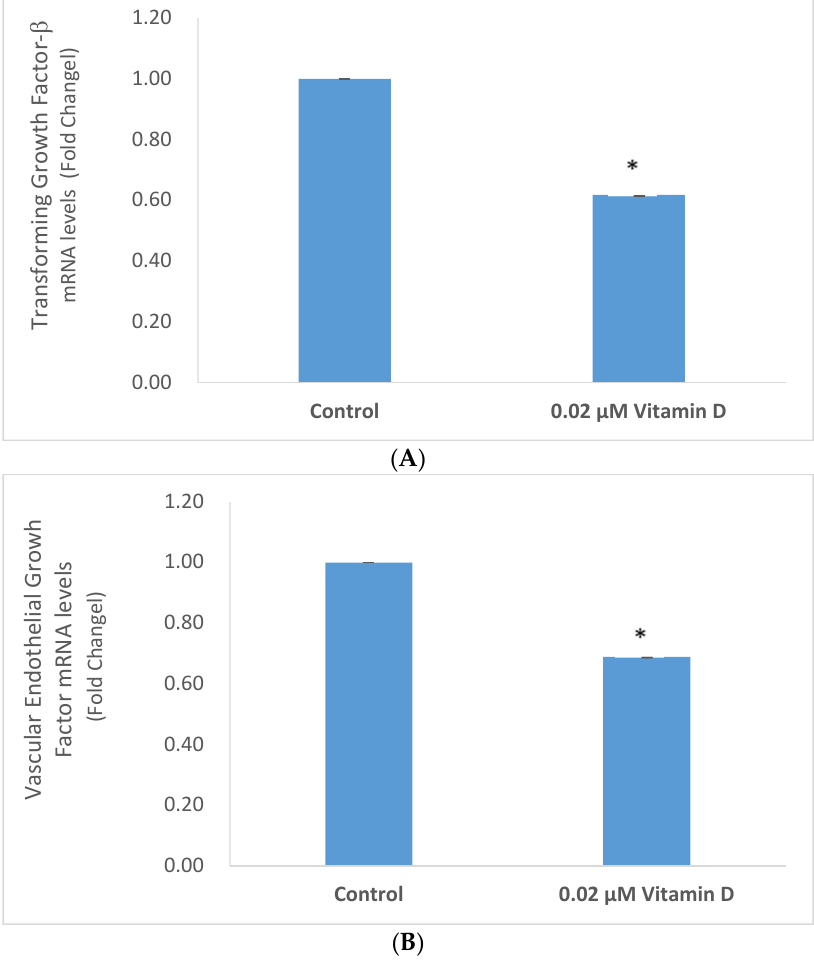
Figure 6. Effect of 0.02 μM 1 α ,25-dihydroxyvitamin D3 (vitamin D) on transforming growth factor beta (TGF-β) ( A ), and vascular endothelial growth factor (VEGF) ( B ) mRNA levels in melanoma cells; error bars: standard deviation, n = 4; * = p < 0.05, relative to control.